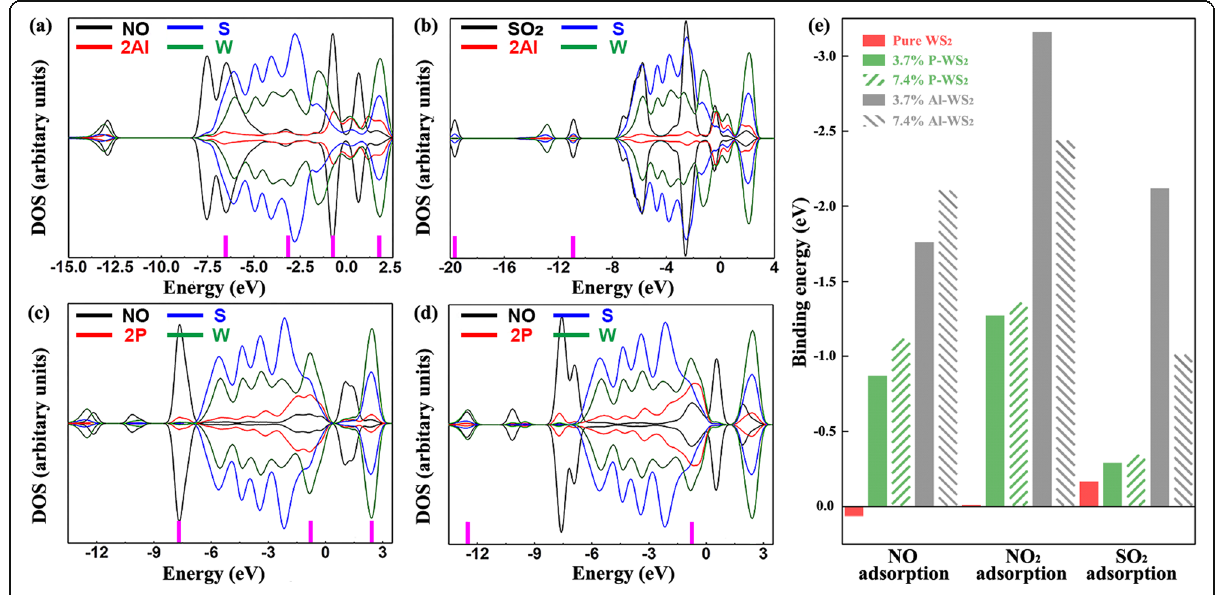
Fig. 7 DOS of a NO, 2Al-1, S, and W atoms; b SO 2 , 2Al-1, S, and W atoms; c NO, 2P-1, S, and W atoms; and d NO, 2P-3, S, and W atoms. e Binding energies of all the adsorption